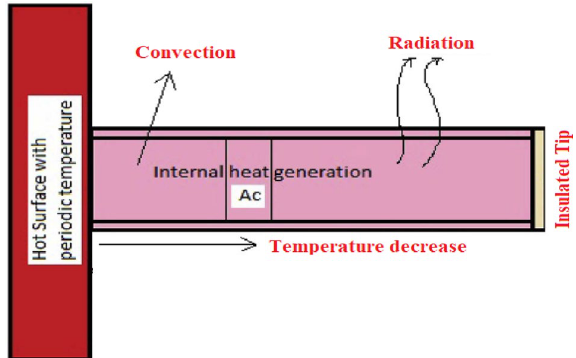
Figure 1. Configuration of longitudinal fin in terms of one